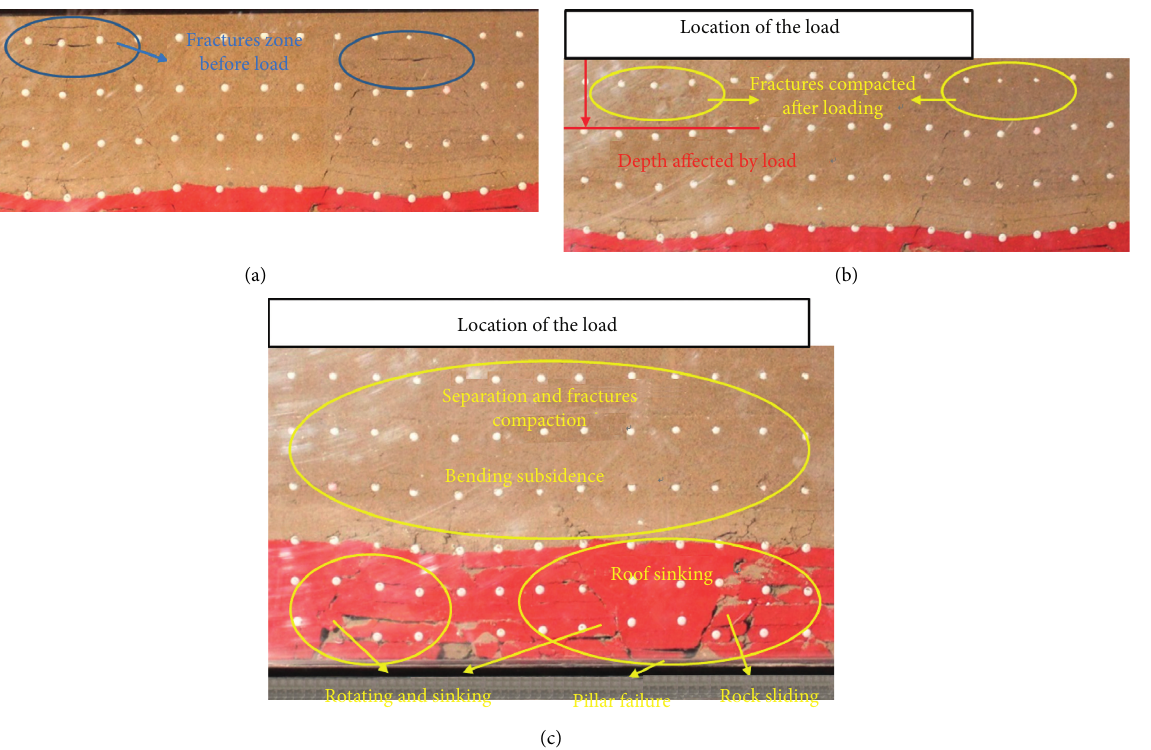
Figure 12: (a) Fracture distribution of the loose layer after mining; (b) fracture closure of the loose layer under the action of the first level of loading; (c) fracture distribution of the gob when coal pillar instability occurs under the third level of